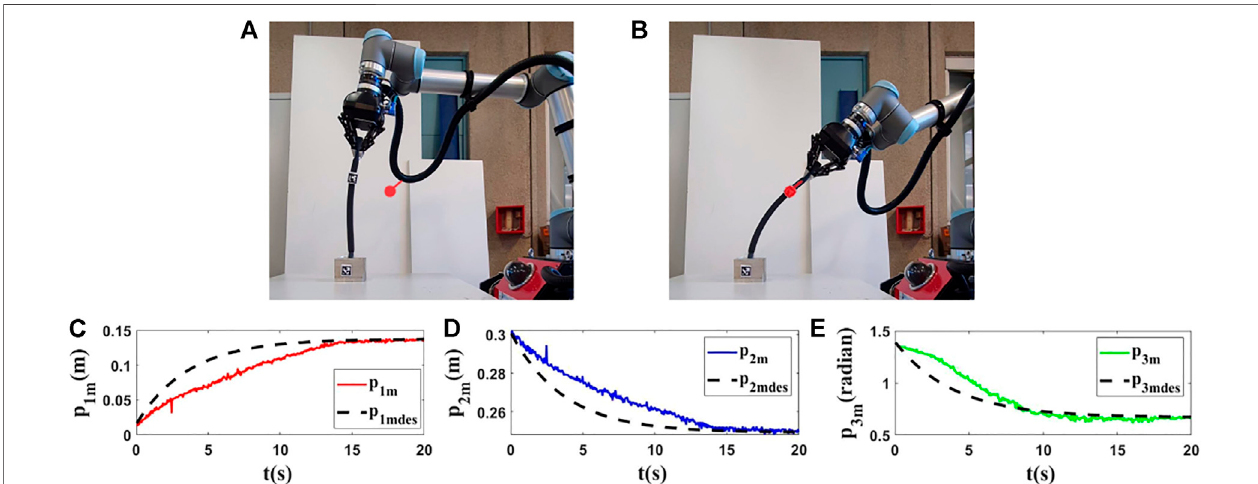
FIGURE10| Experiment1.Firstrow: (A) and (B) aretheinitialand fi nalshapeoftheobject,respectively.Thedesiredstateof m isshownasaredcirclewithasmall linesegment.Inthistest,weassumethat M 0 is[0.016,0.300,1.428] T andwewanttomoveitto M fdes =[0.140,0.250,0.665] T .The fi nalstateofthecontrolledpointis M f = [0.137,0.247,0.661] T . Second row: (C) , (D) and (E) are the evolution of the states in the fi rst experiment with respect to their desired trajectories.